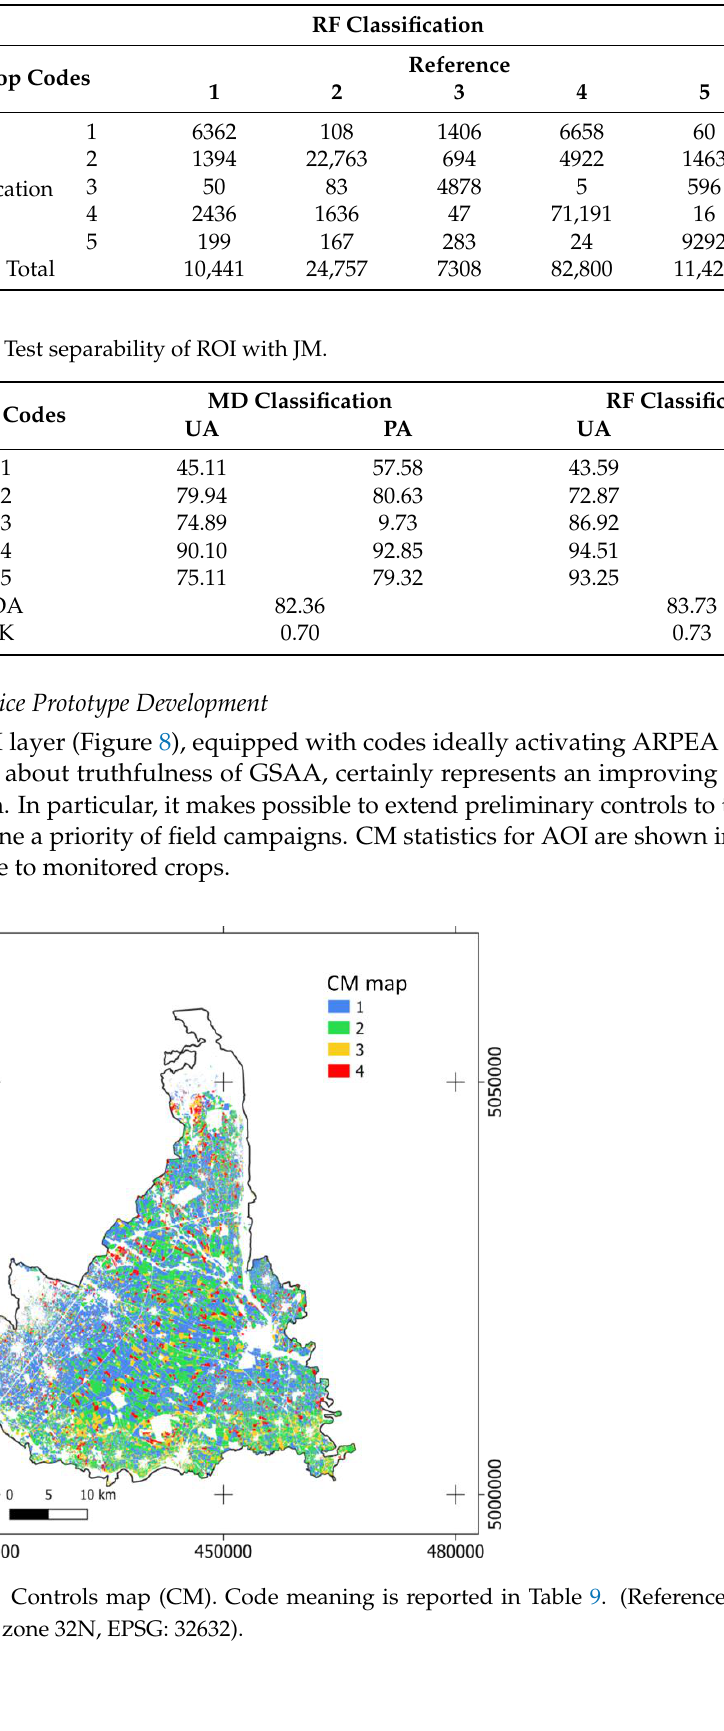
Table 11. Confusion matrix of AOI performed by RF classification.